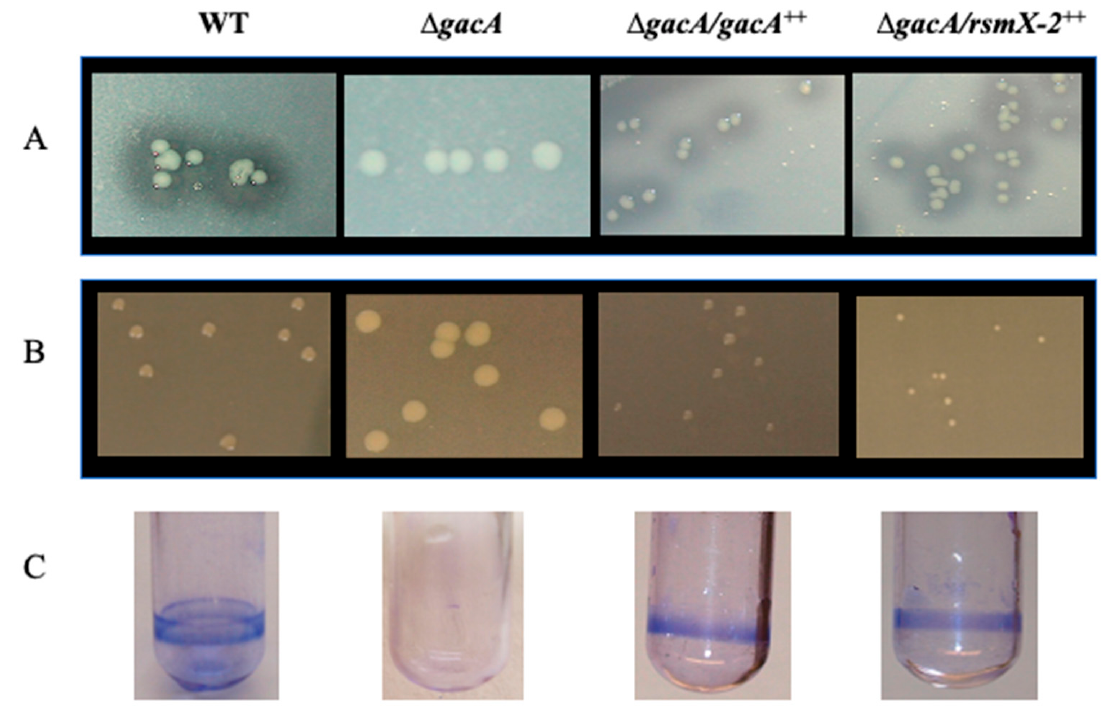
Figure 4. rsmX -2 restores GacA-dependent phenotypes. Restoration of wild-type phenotype by overexpression of rsmX-2 from a plasmid under the control of P tac promoter in gacA cells as determined by ( A ) Protease activity on skimmed milk-containing medium, ( B ) Colony morphology on PAF medium and ( C ) Biofilm formation.